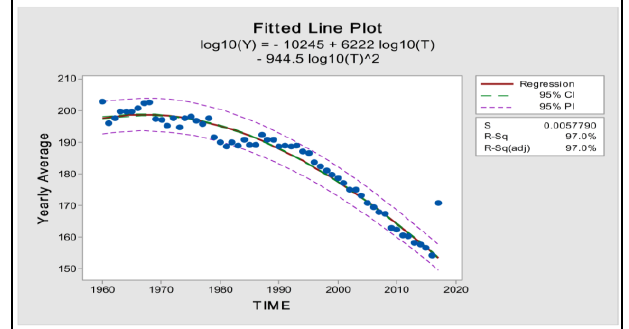
Figure 4 : Polynomial regression analysis graph showing quadratic equation modeling, Confidence Interval (CI) and Prediction Interval (PI) along with R 2 and the Standard Error of the Regression (S), generated using Minitab v17.1.0.